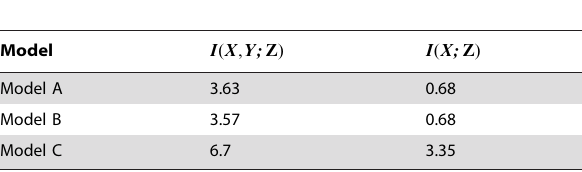
Table 1. Mutual Information